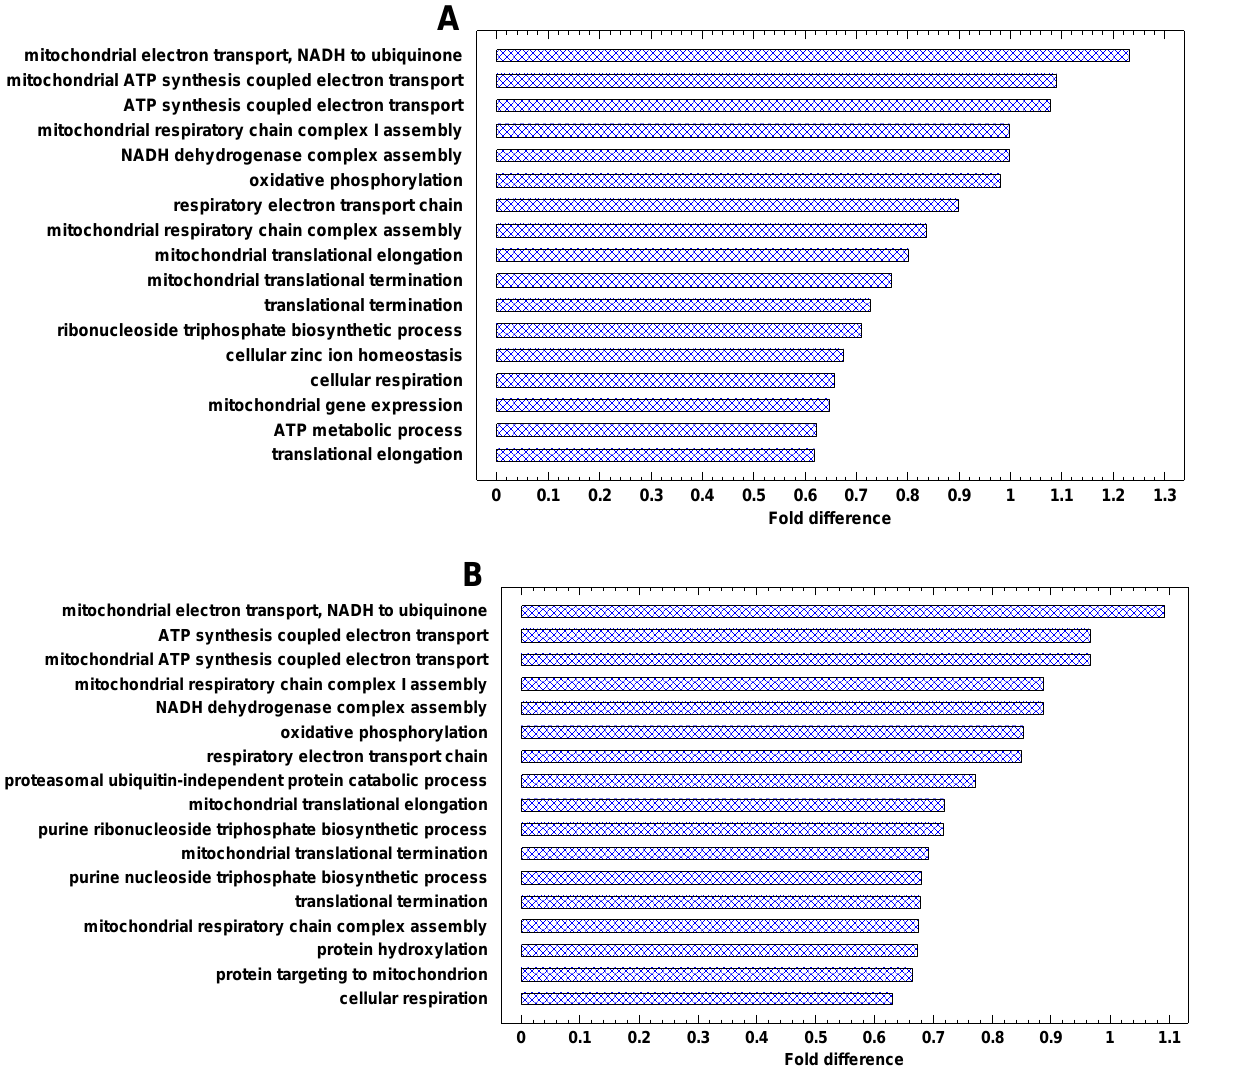
Figure 6. The most strongly enriched GO Biological Processes in the genes that are upregulated in cancers. Fold difference: the difference between the mean cancer/normal expression fold for a given process and the mean fold for all processes (log2). The processes with the highest folds (and having >20 genes) are shown: ( A ) breast cancer ( p < 0.0001 at least); ( B ) melanoma ( p < 0.0001 at least).